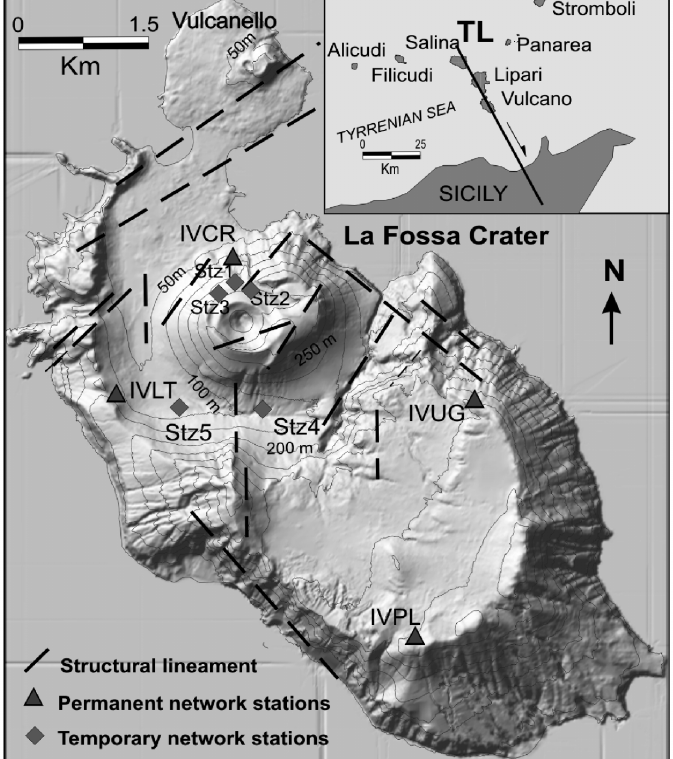
Fig. 1. Map of the Vulcano permanent and temporary seismic network. Structural lineaments from Mazzuoli et al. ,